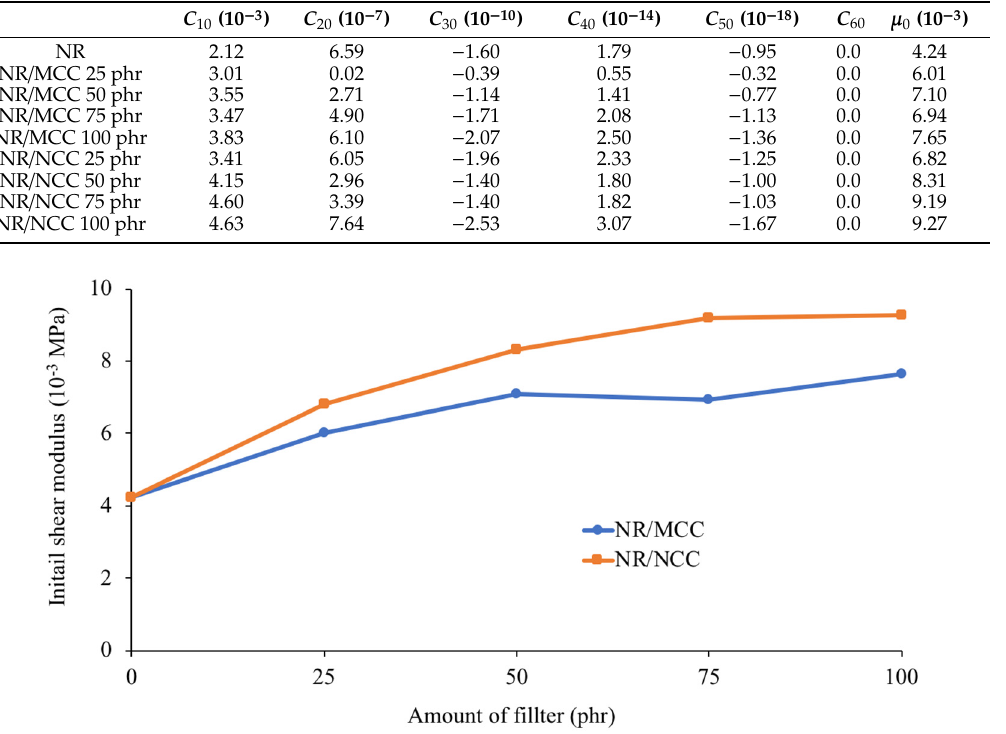
Figure 6. The initial shear modulus, μ (cid:2868) , at different loading of MCC and NCC.